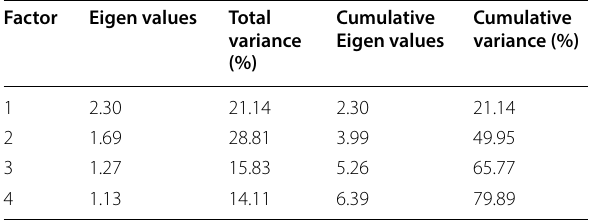
Table 7 Factor loadings obtained with unroasted factor matrix (surface samples)